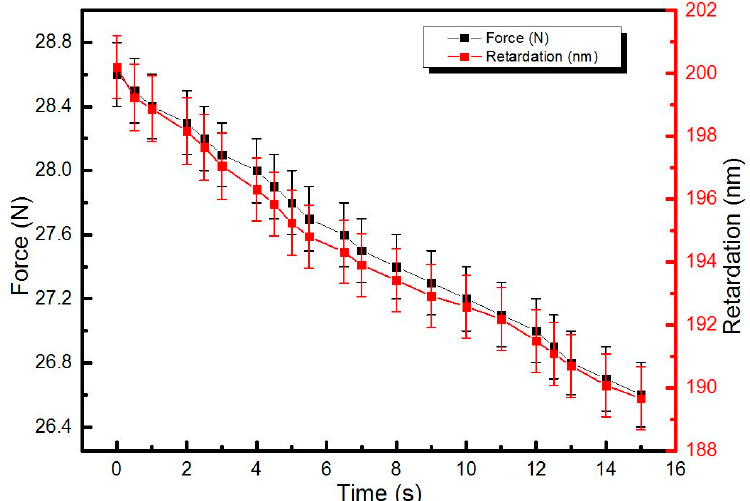
Figure 6. Stress relaxation of PI membrane in uniaxial tension mode, where the black line stands for the force value against time and the red line represents the retardation value against time.